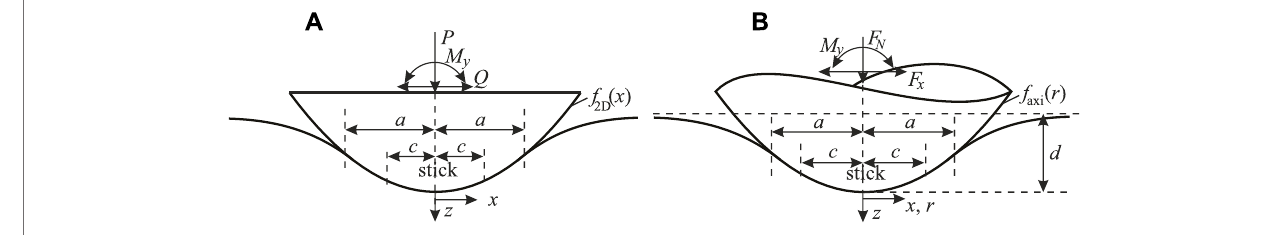
FIGURE 1 | Oscillating tangential contact between a rigid indenter and an elastic half-space. (A) plane contact (B) axisymmetric